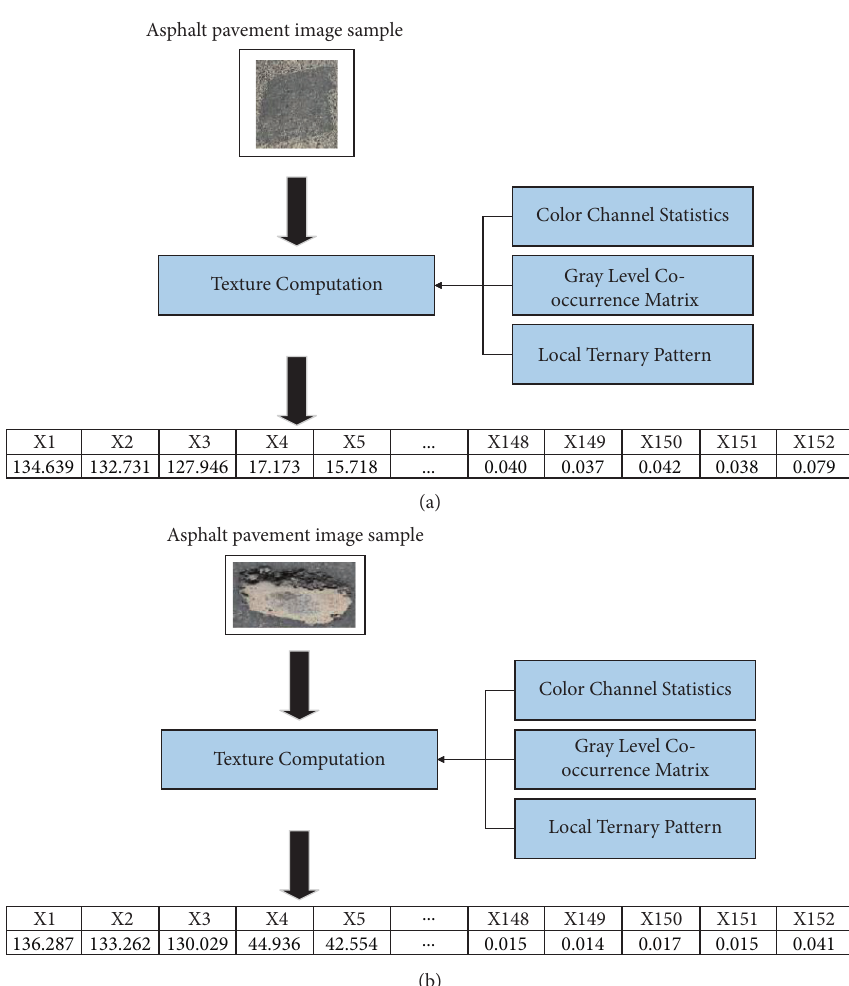
Figure 7: Demonstration of the feature extraction process: (a) a sample of the “patched pothole” class and (b) a sample of the “pothole”